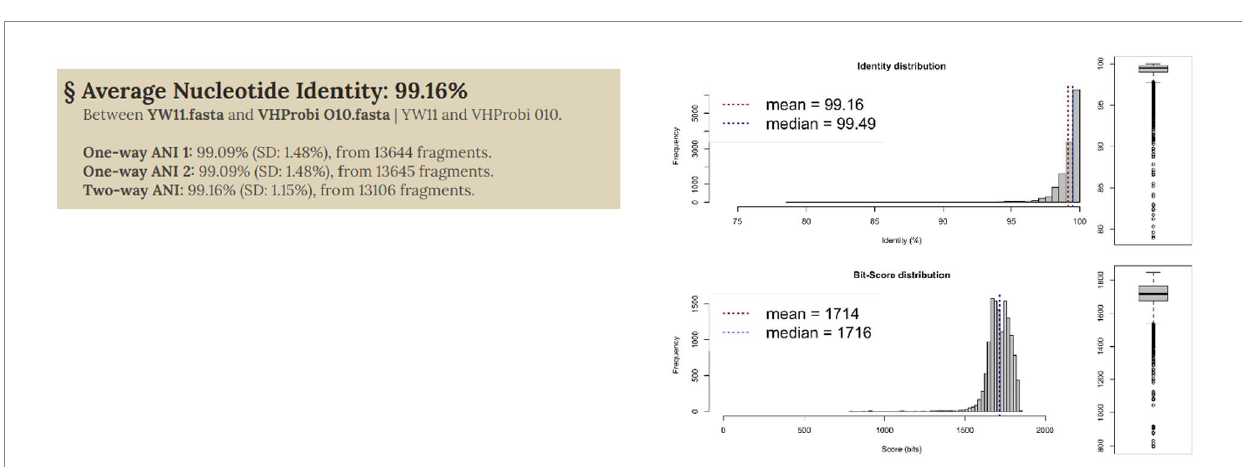
FIGURE 3 ANI analysis of genome to shows genomic